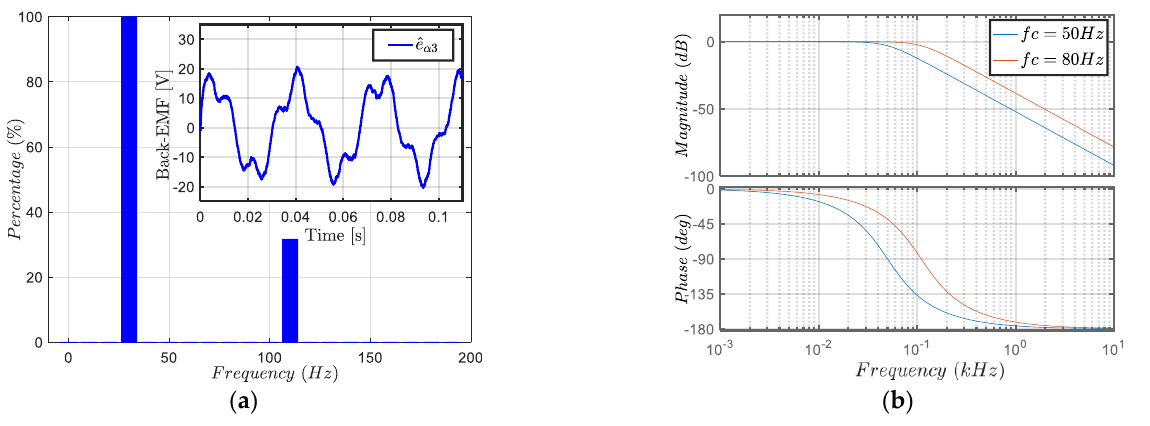
Figure 12. Simulation waveforms: ( a ) harmonic spectrum of the estimated back EMF of the 3rd harmonic TM, ( b ) Bode diagram of the second order low pass filter.